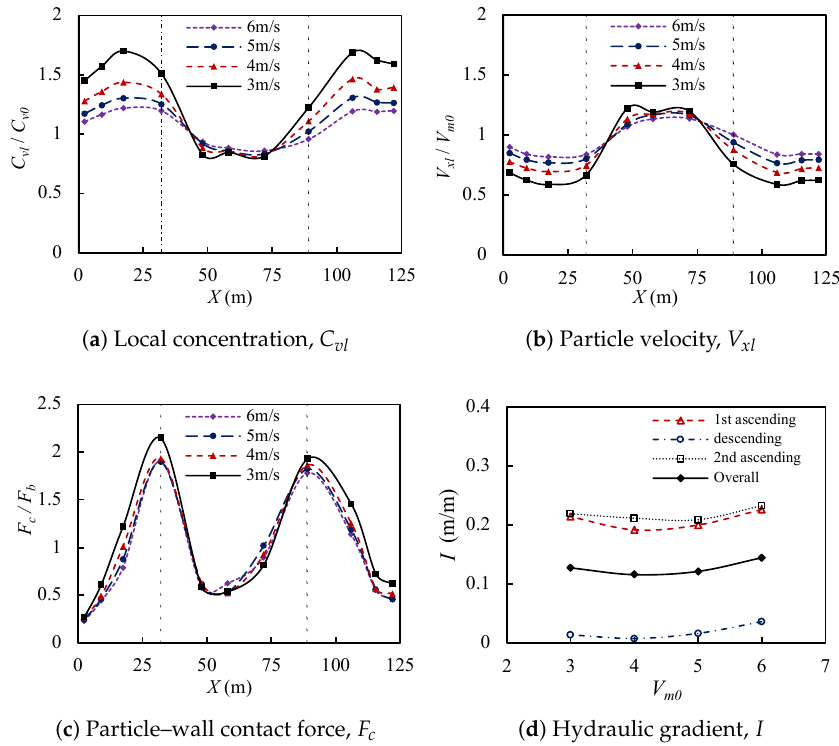
Figure 13. Effect of mixture transport velocity V m 0 (at C v 0 =